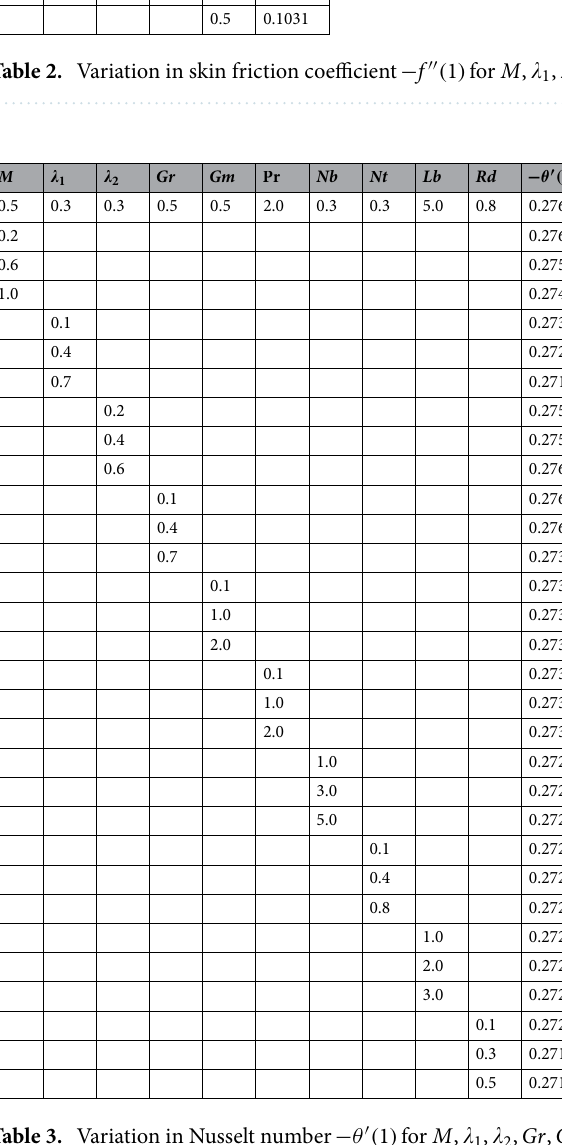
Table 3. Variation in Nusselt number